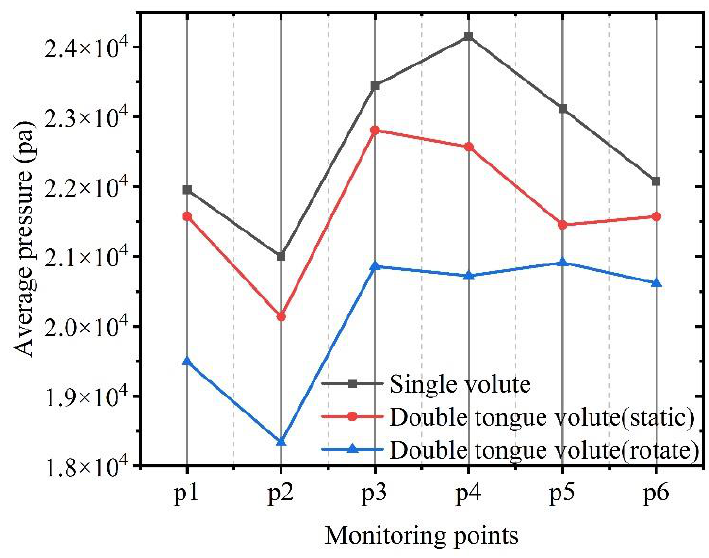
Figure 8. The variation trend of average pressure with different volutes.